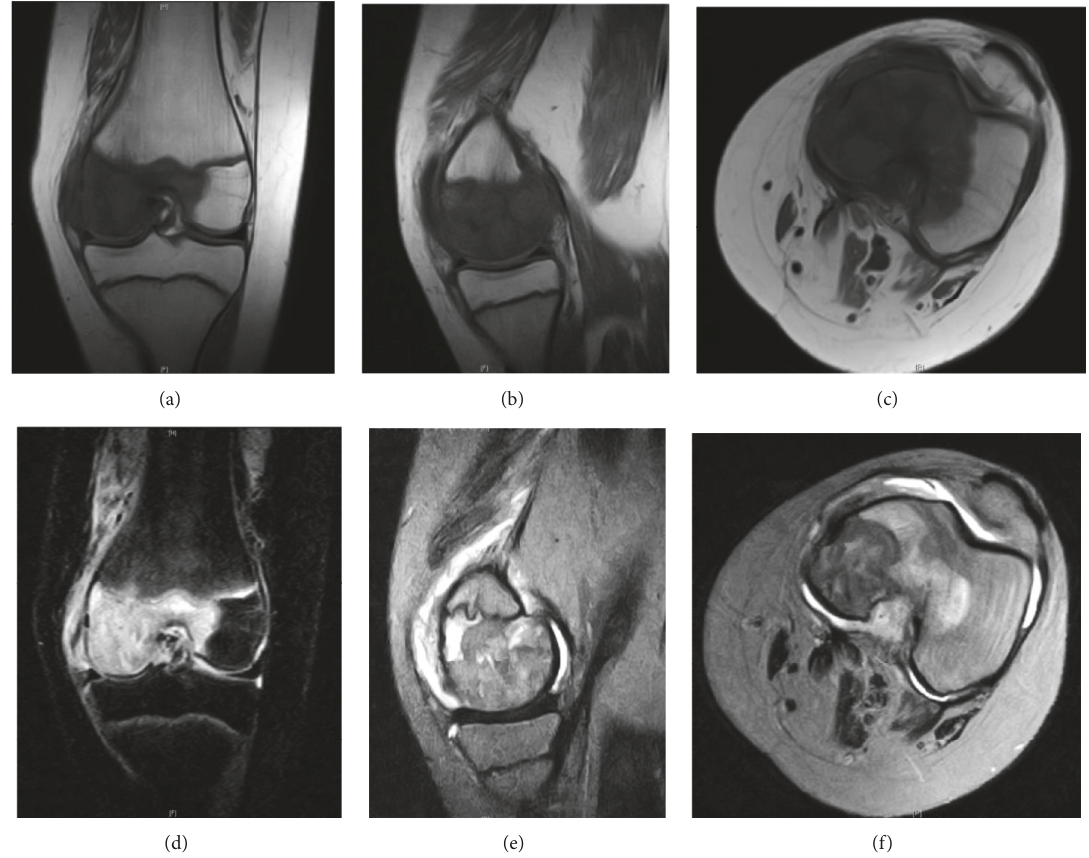
Figure 2: Magnetic resonance images (MRI): T1 coronal, sagittal, and axial views (a, b, c), STIR coronal (d), T2 sagittal (e), and axial views (f) of the left knee, July 2009.